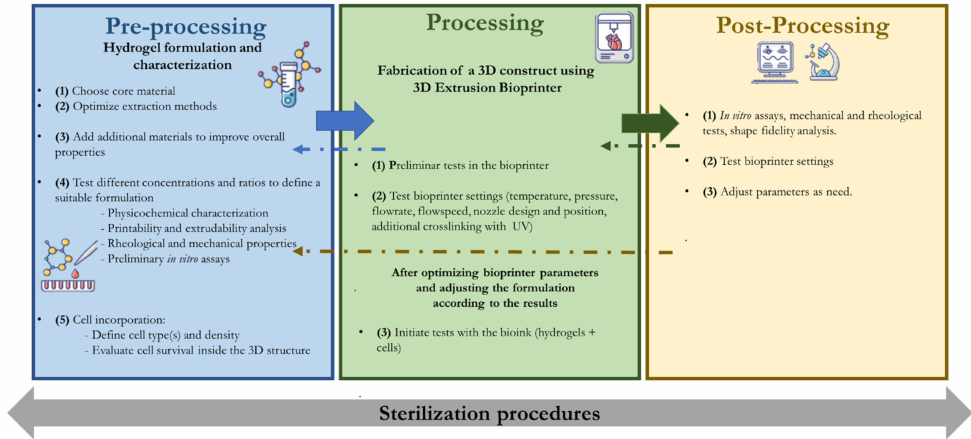
Figure 5. Schematic representation of the steps that must be considered in the development of a